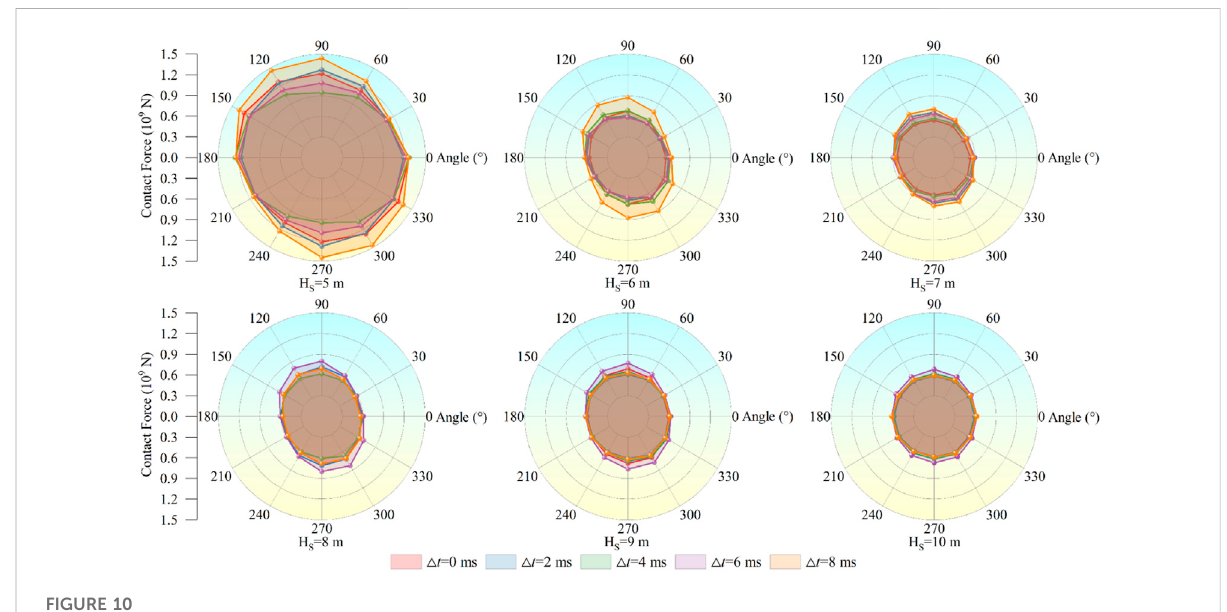
FIGURE 10 Contact force information after blasting in soft